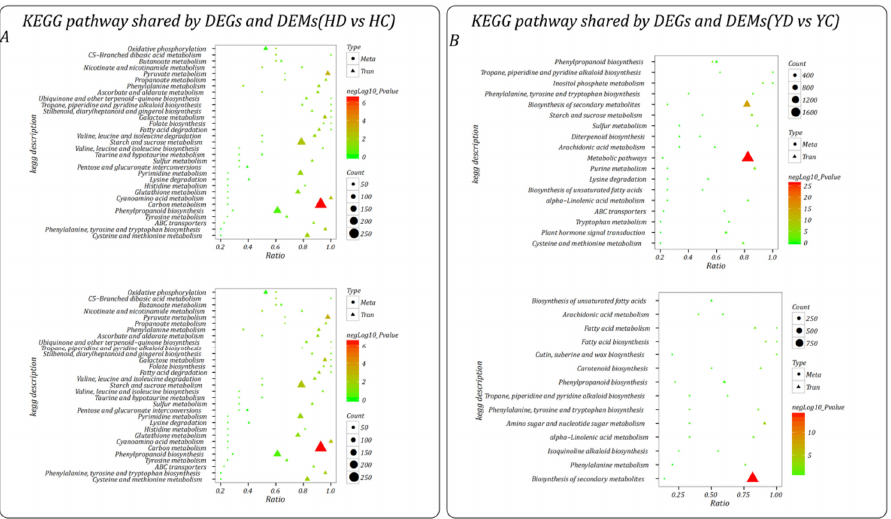
Figure A3. Molecular pathways shared by DEGs and DEMs. ( A ): KEGG pathways shared by the DEGs and DEMs in the HD vs. HC comparison. ( B ): KEGG pathways shared by the DEGs and DEMs in the YD vs. YC comparison.